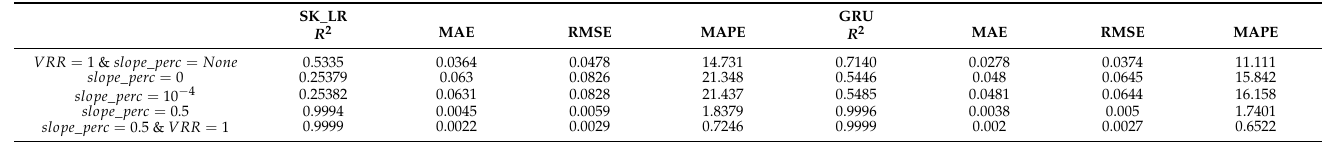
Table 5. Different slope values for the Mercari dataset.